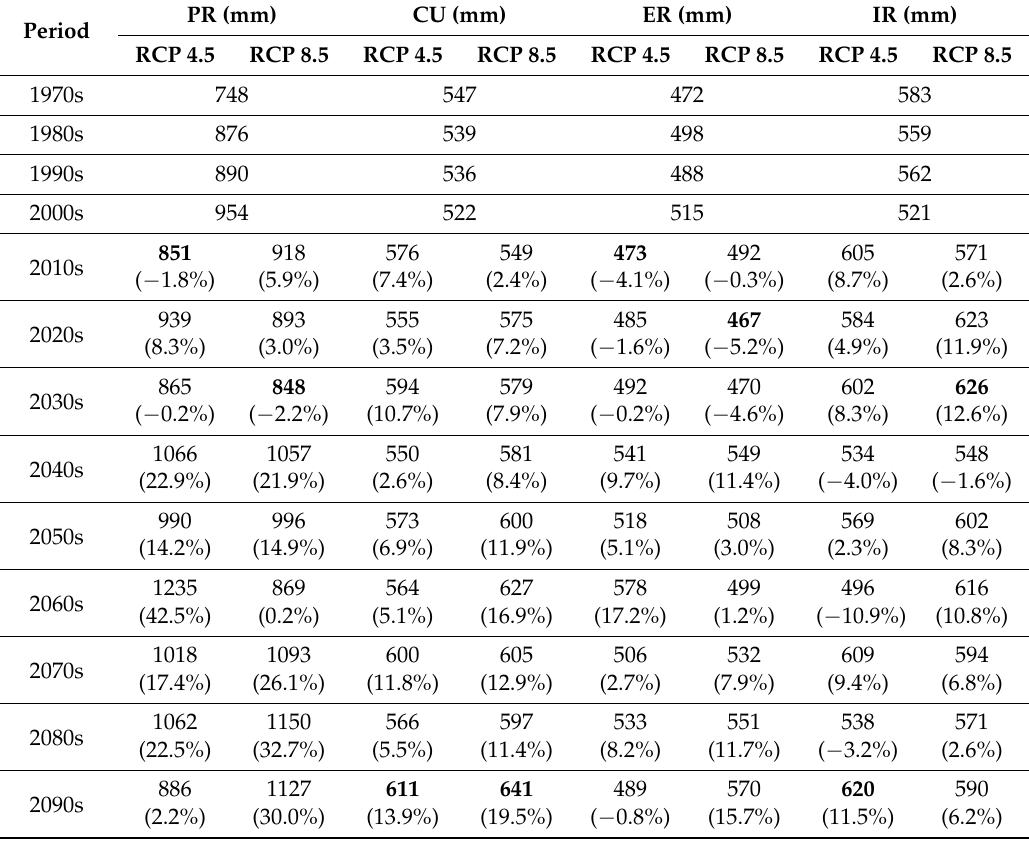
Table 4. Results of annual precipitation, consumptive use, effective rainfall, and net water requirements for paddy fields under RCP scenarios in South